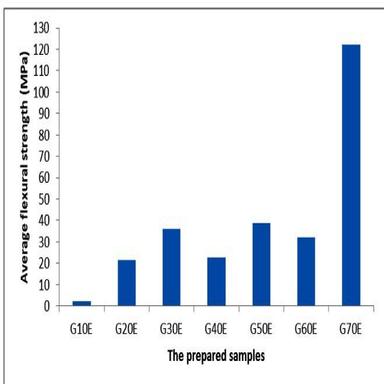
Flexural strength of the investigated glasses after heat -treatment at550◦C, 2h then at 800◦C, 2h.